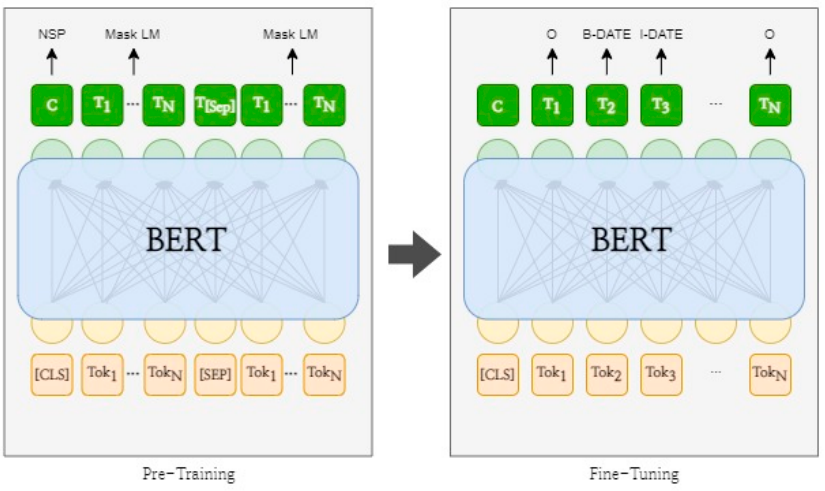
Figure 4. BERT architecture and fine-tuning process.